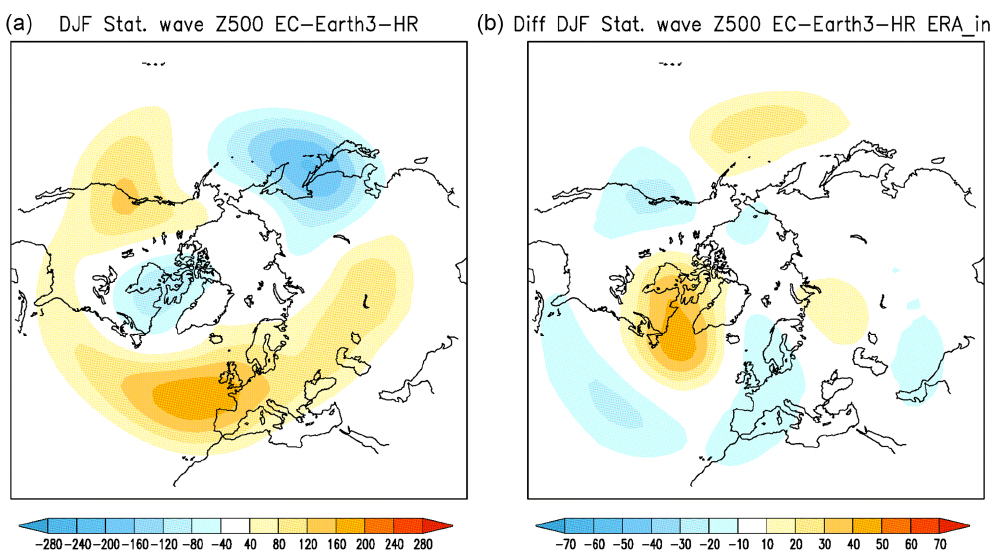
Figure 9. (a) Stationary eddy component (departure from zonal mean) of EC-Earth3P-HR of the 500hPa geopotential height (m) in boreal winter; (b) the difference with ERA5. Note the difference in color scale between the two